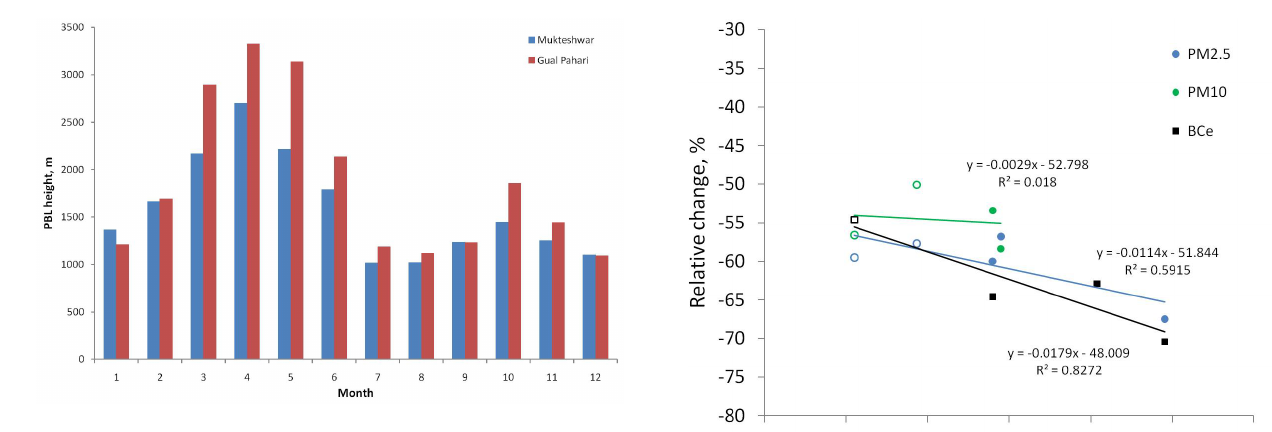
Fig. 3. Annual variation for the averaged daily maximum bound- ary layer heights (PBL) obtained from the European Centre for Medium-Range Weather Forecasts (ECMWF).